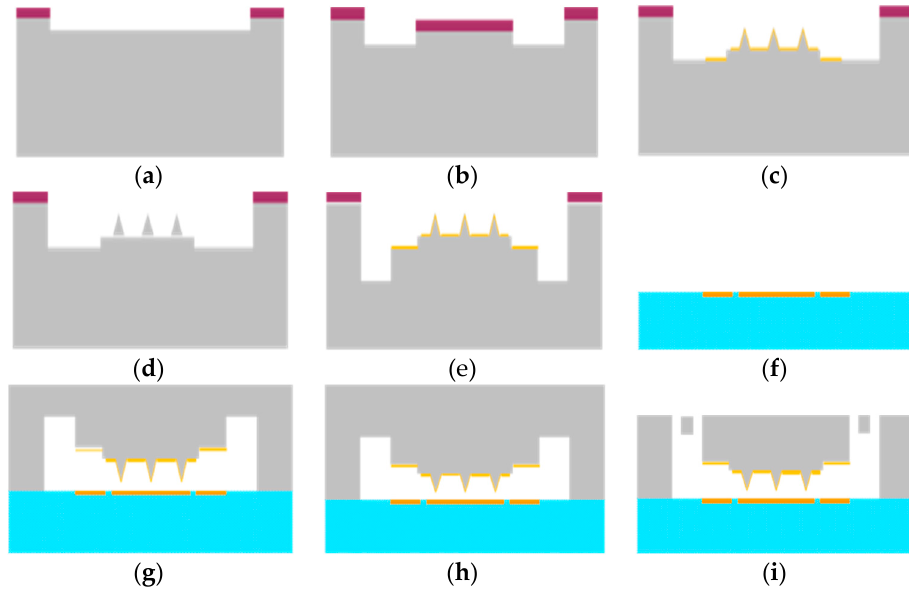
Figure 7. Process of the vacuum microelectronic accelerometer. ( a ) Etching groove windows to form a bonded anchor. ( b ) Etching groove windows to form the cone station. ( c ) Corrosion cone formation and sharpening. ( d ) After ion implantation, cone metallization is performed. ( e ) ICP etching of the front to form the beam area. ( f ) Growth of the electrodes on glass. ( g ) Bonding the silicon and glass. ( h ) The silicon is thinned by KOH etching. ( i ) ICP structure release to form the beam.